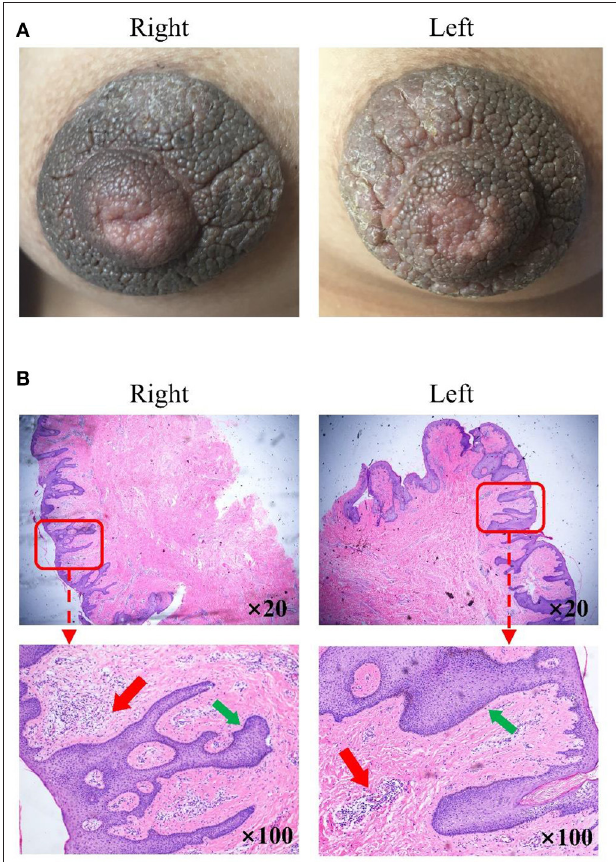
FIGURE 1 | Clinical images and histological detection of hyperkeratosis of the nipple and areola (HNA). (A) Nevoid hyperkeratosis-like lesion of the nipple and areola in the right and left mammary areas. (B) Stained sections were observed under a fluorescence microscope magnification in the right and left mammary areas. Hematoxylin-eosin stain; original magnification, × 20 and × 100. The thin red arrow indicates immune cell infiltration in a significant number of samples. The thin green arrow indicates epidermal hyperplasia was also